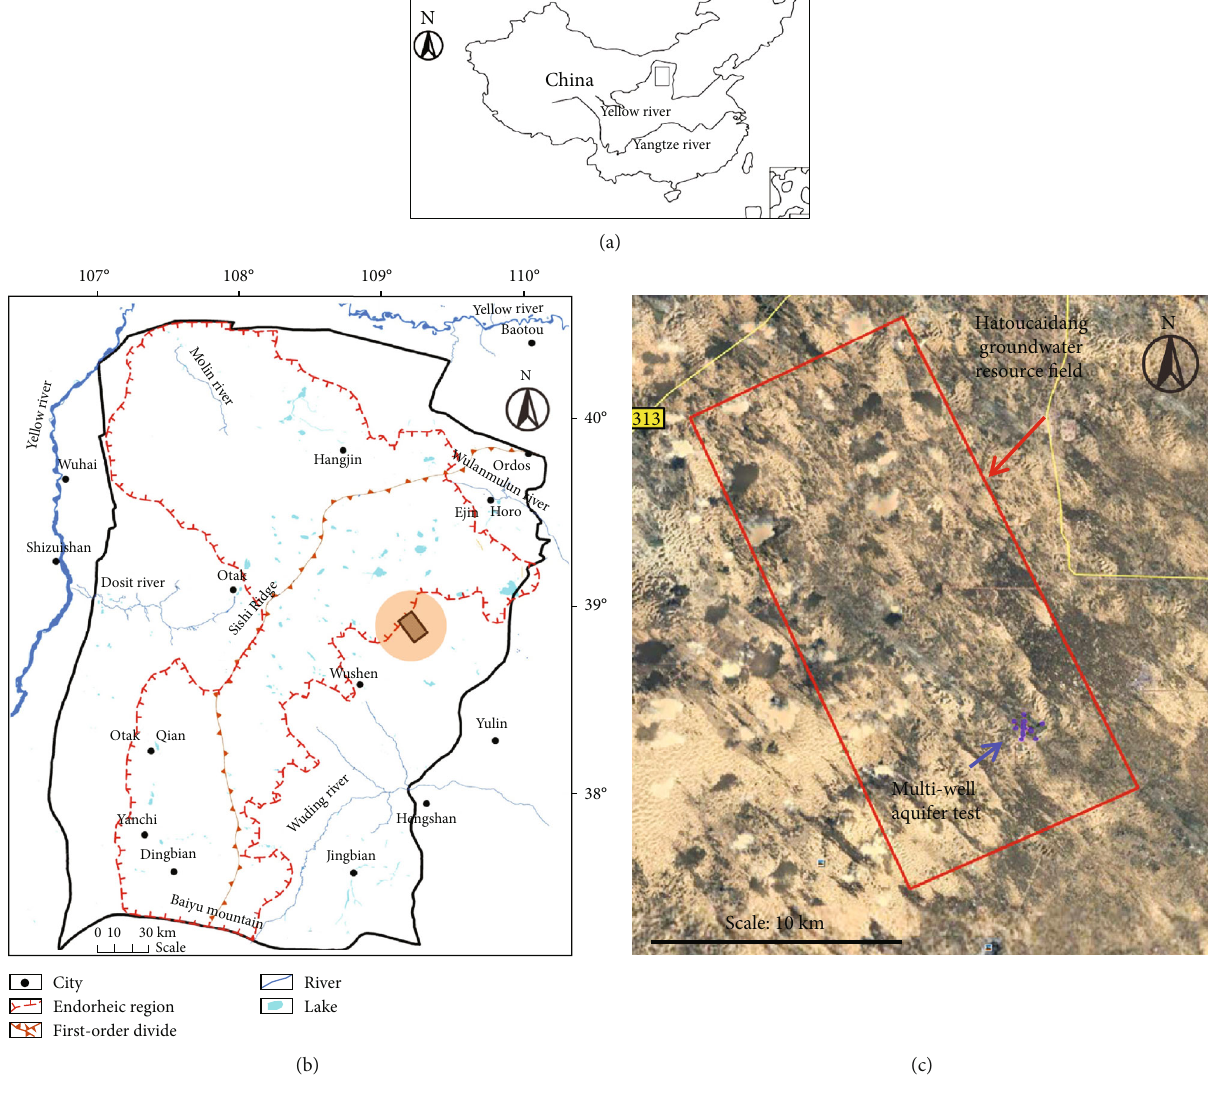
Figure 2: (a) Location of the Ordos Plateau. (b) Location and (c) the Google image of the Hatoucaidang water resource fi eld. In (c), the red rectangle outlines the Hatoucaidang groundwater resource fi eld and the blue dots resemble pumping and observation wells of the multiwell aquifer